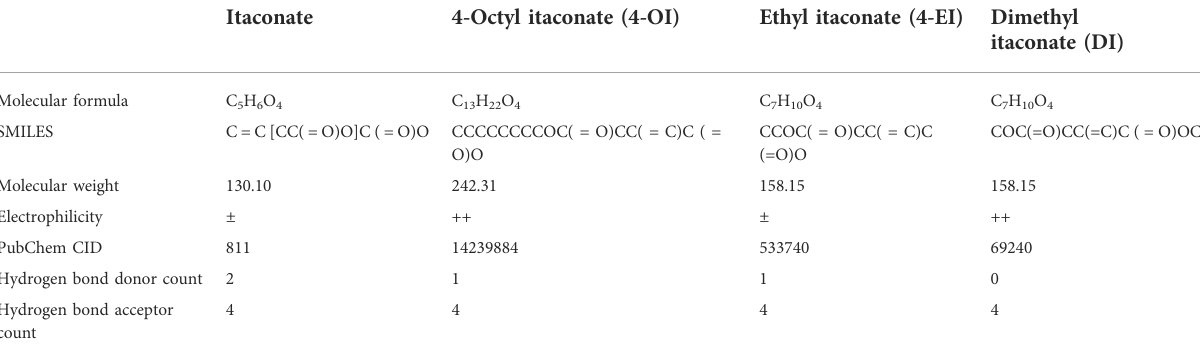
TABLE 4 The information sheet of itaconate and its derivatives